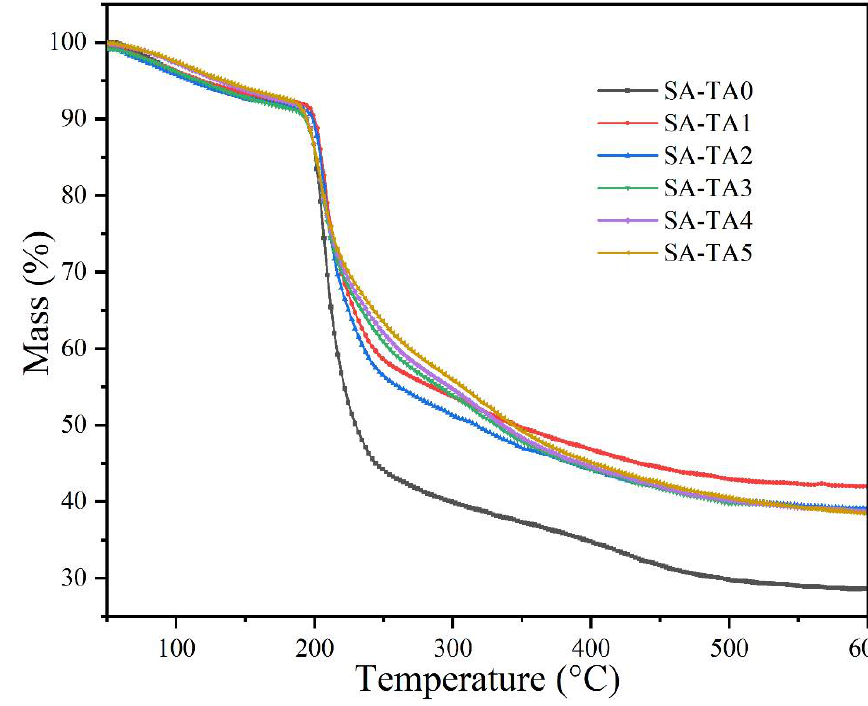
Figure 8. TGA curves of SA and SA-TA films.